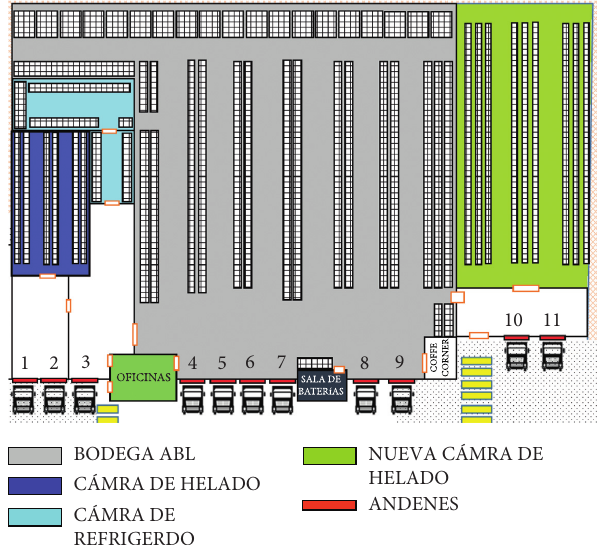
Figure 1: Structural warehouse layout, Concepci´on IDC, section: operations warehouse (source: emergency layout, Concepci´on